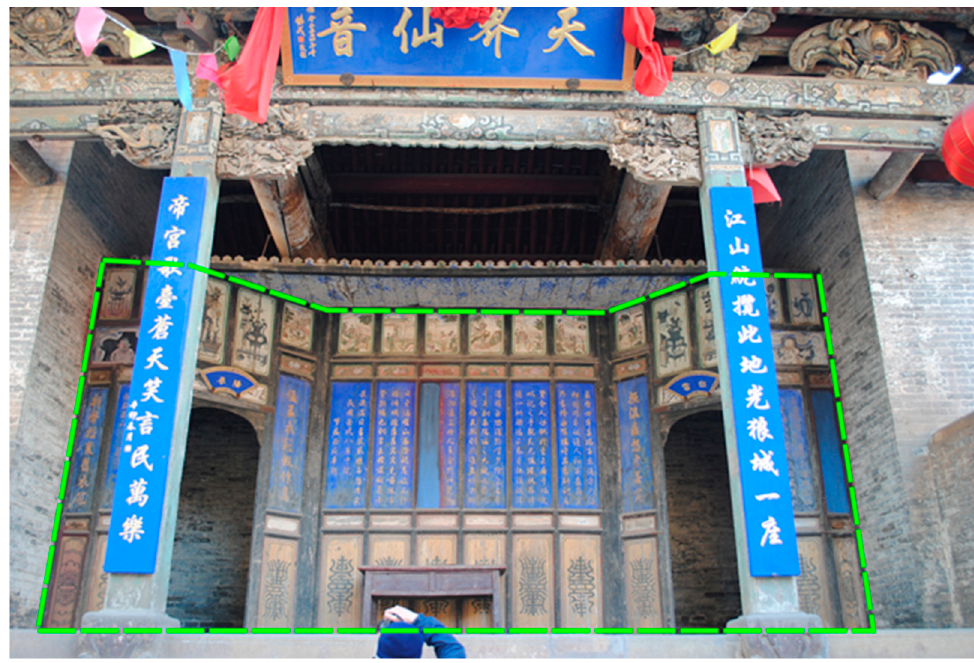
Figure 11. A screen relic in the backyard playhouse of the Chengtang Temple in the Kangying Village, Macun Town (No. 55 in Figure 1).